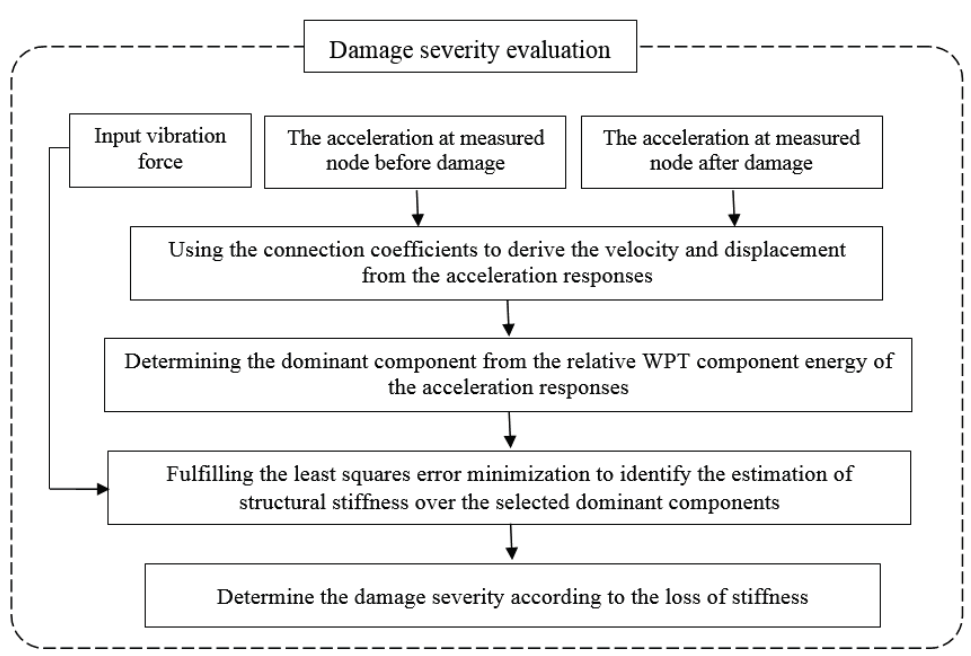
Figure 2. Diagram of damage severity